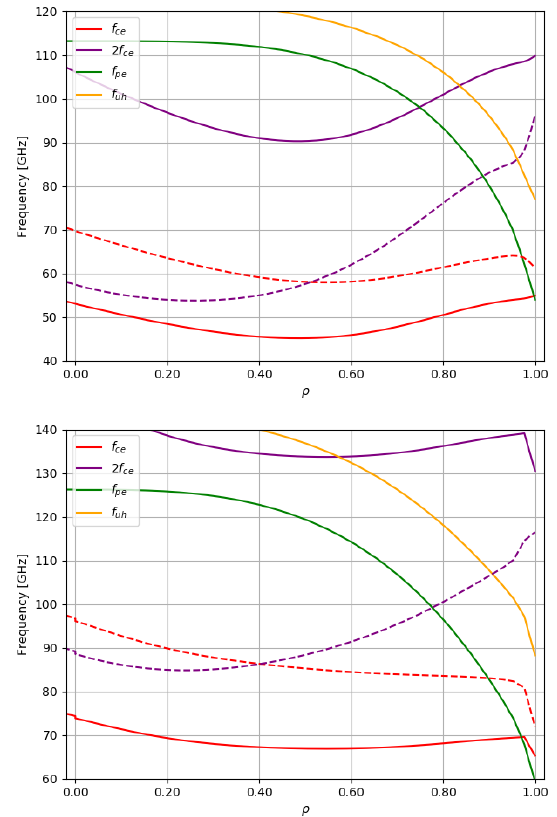
Figure 9. Estimate of EBW absorption on midplane for SPR- 008 (top) and SPR-046 (bottom) for 𝑁 ∥ = 0.65 . The cold 1 st (red) and 2 nd (purple) cyclotron harmonic frequencies and predicted 1 st harmonic upshift / 2 nd harmonic downshift from (3) (dashed) are shown. The plasma frequency (green) and upper hybrid frequency (orange) are also